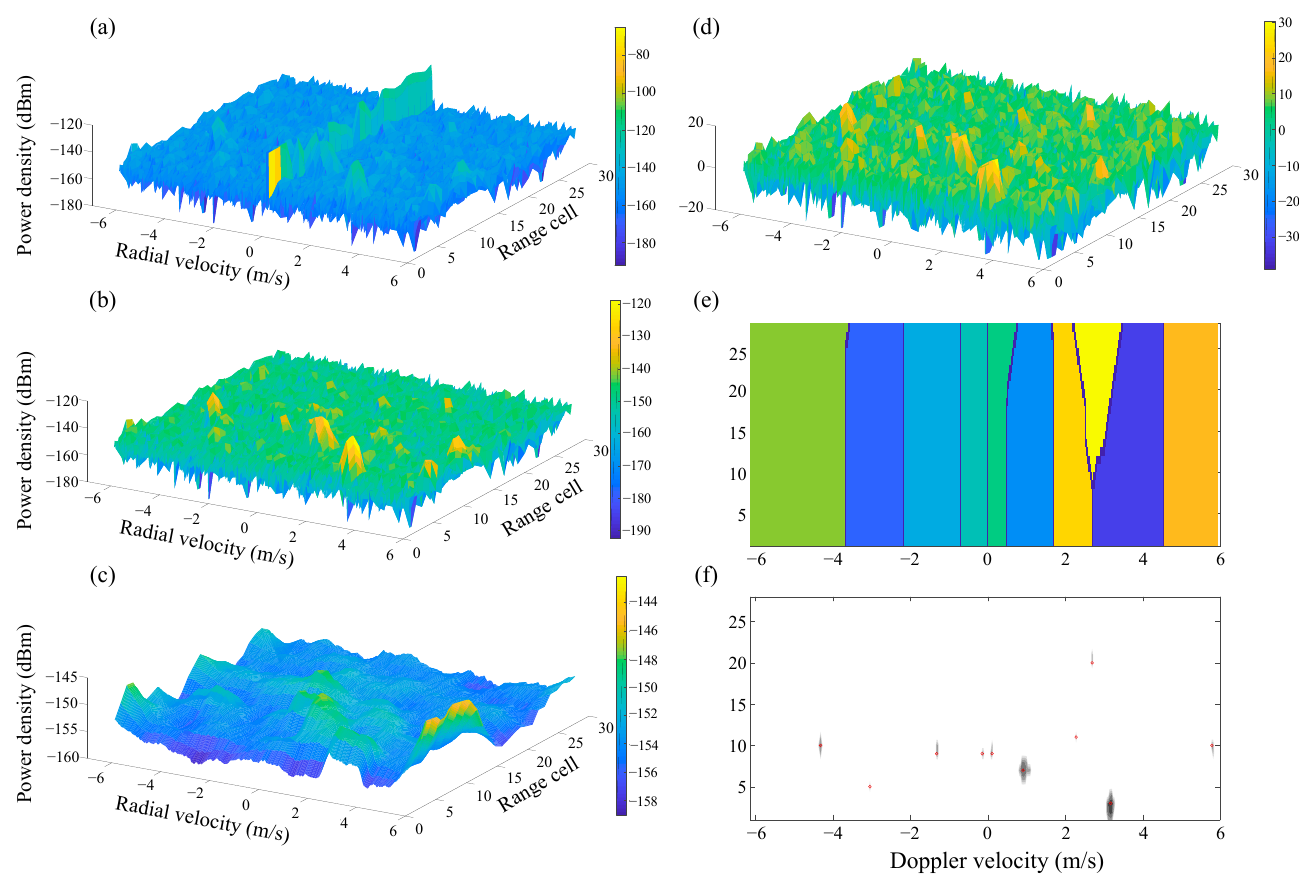
Figure 6. Schematic results of each step in the ASI algorithm: ( a ) An ROI of CSS has a strong echo at zero velocity; ( b ) DC removal of Figure 6a; ( c ) Moving average surface of Figure 6b; ( d ) Residual series; ( e ) The watershed algorithm divides a suspected ship echo into separate regions; ( f ) Location of the local peak of each suspected vessel (red circle).